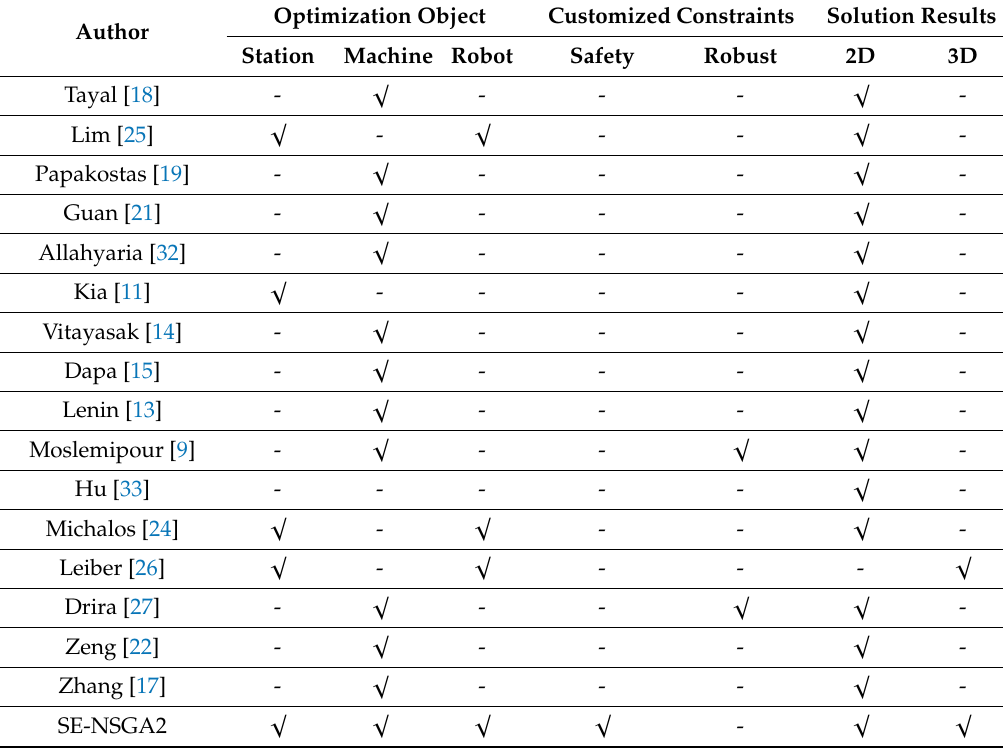
Table 1. Comparison based on the characteristics of the facility layout problems